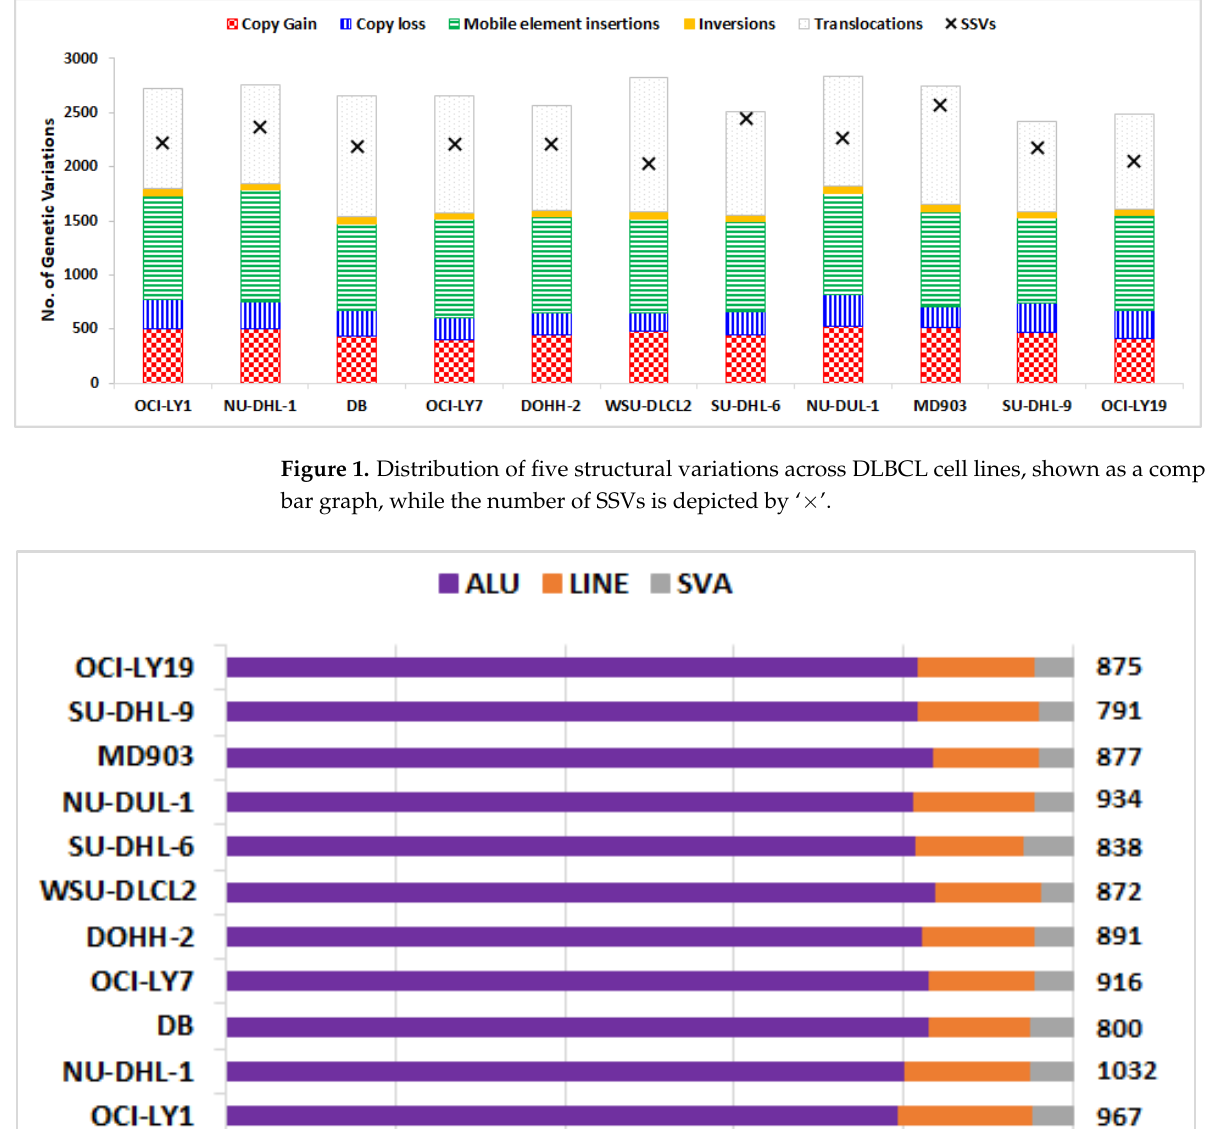
Figure 2. Fraction of three classes of mobile element insertions (MEIs), viz., ALU, LINEs, and SVA. Total number of MEIs per cell line is indicated on the right panel.